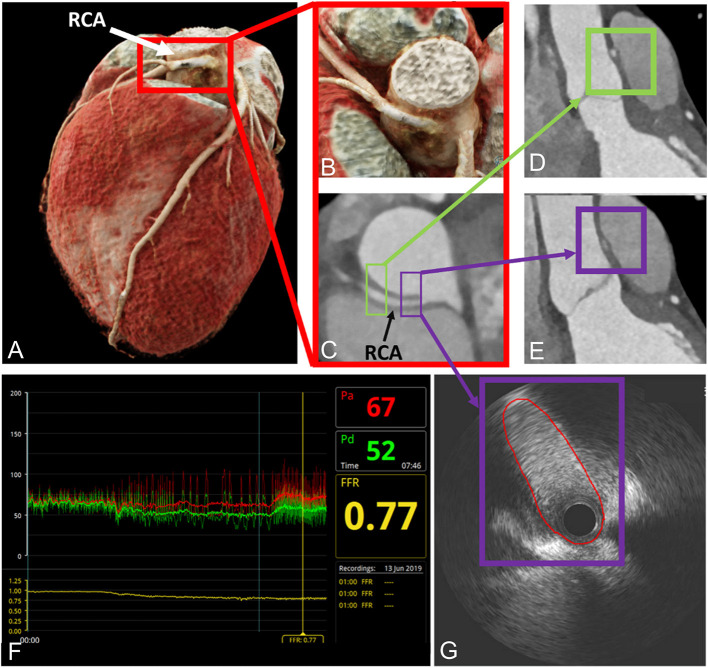
Depiction of anatomical high-risk features in a patient with right ACAOS by coronary computed tomography angiography and invasive coronary angiography. (A–C) Illustration of the interarterial course by CCTA; (D,E) depiction of anatomical high-risk features [acute-take off-angle, proximal narrowing and oval vessel shape; purple box proximal segment, also called Angelini/Cheong sign (29), green box distal segment]; (F,G) invasive assessment with a positive FFR and demonstration of lateral compression by intravascular ultrasound. Red line depicts lumen contour. With permission from Elsevier. Bigler et al. (30).